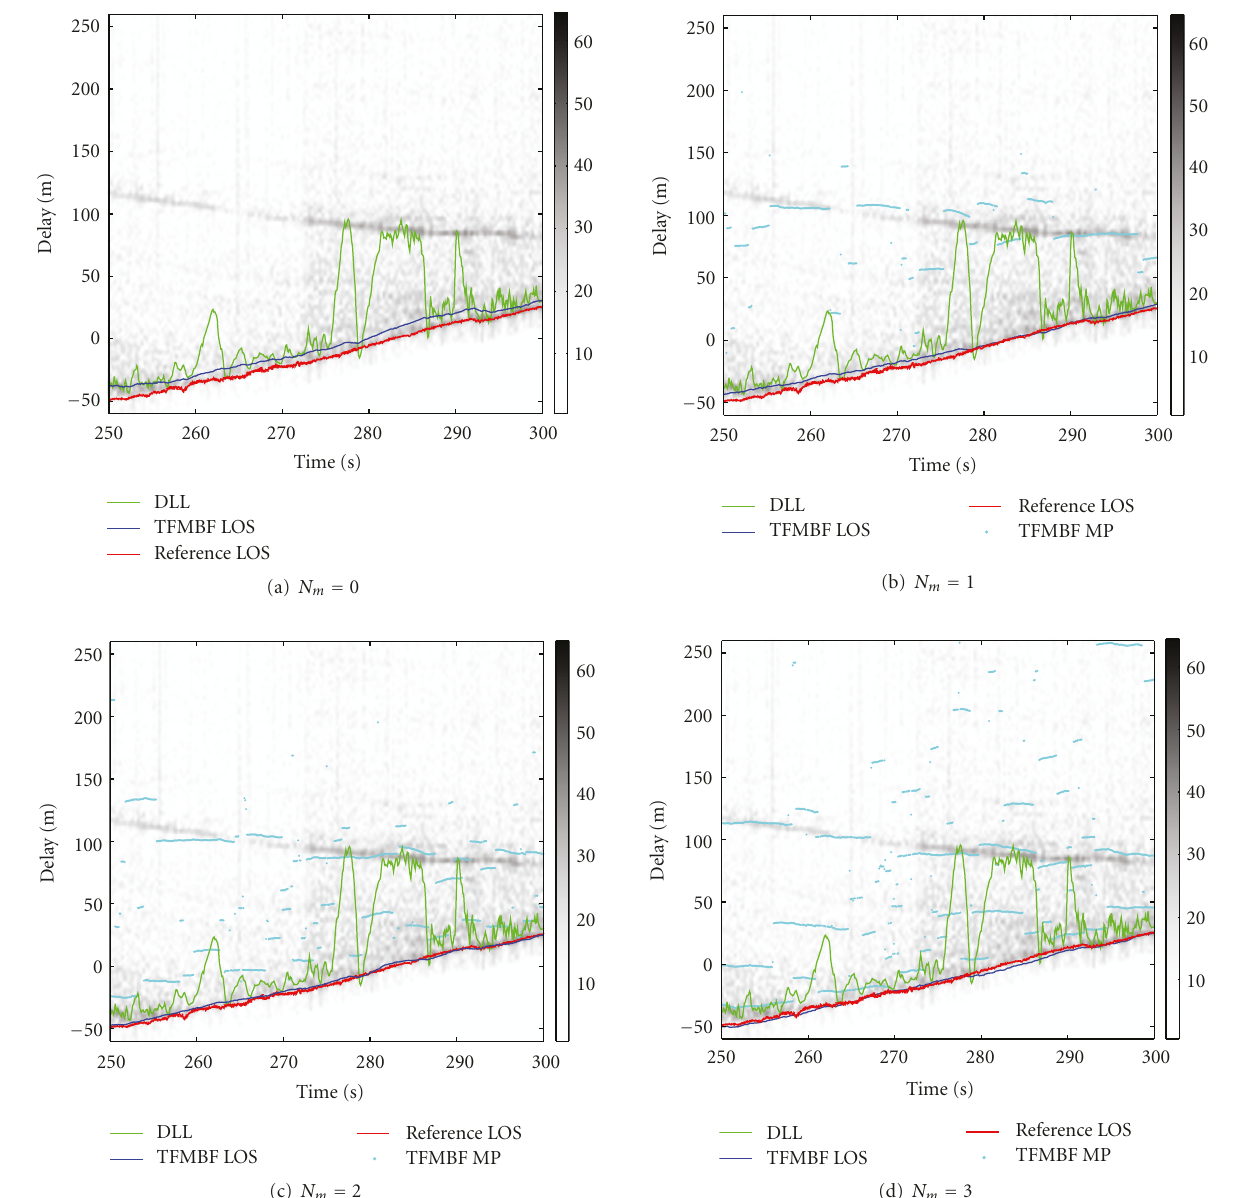
Figure 6: In the illustrated scenario, there is a partially shadowed LOS path (red) that is superimposed by a heavy multipath component. During some periods with weak LOS, the DLL receiver (green) tracks the multipath signal instead of the true LOS, which leads to high errors in the order of 100 meters. The TFMBF’s LOS estimate (dark blue) is still slightly biased if the multipath replicas are not taken into account by the estimator ( N m = 0, (a)). Nevertheless, the magnitude of the errors is much smaller than the DLL errors, since the dynamic model of the estimator prevents fast variations of the LOS estimate and also because phase information is being used implicitly. Once the number of considered replicas is su ffi cient to take into account multipath signals ( N m > 0, (b, c, d)), the estimation algorithm detects and properly tracks the additional replicas (light blue), and thus successfully mitigates the multipath